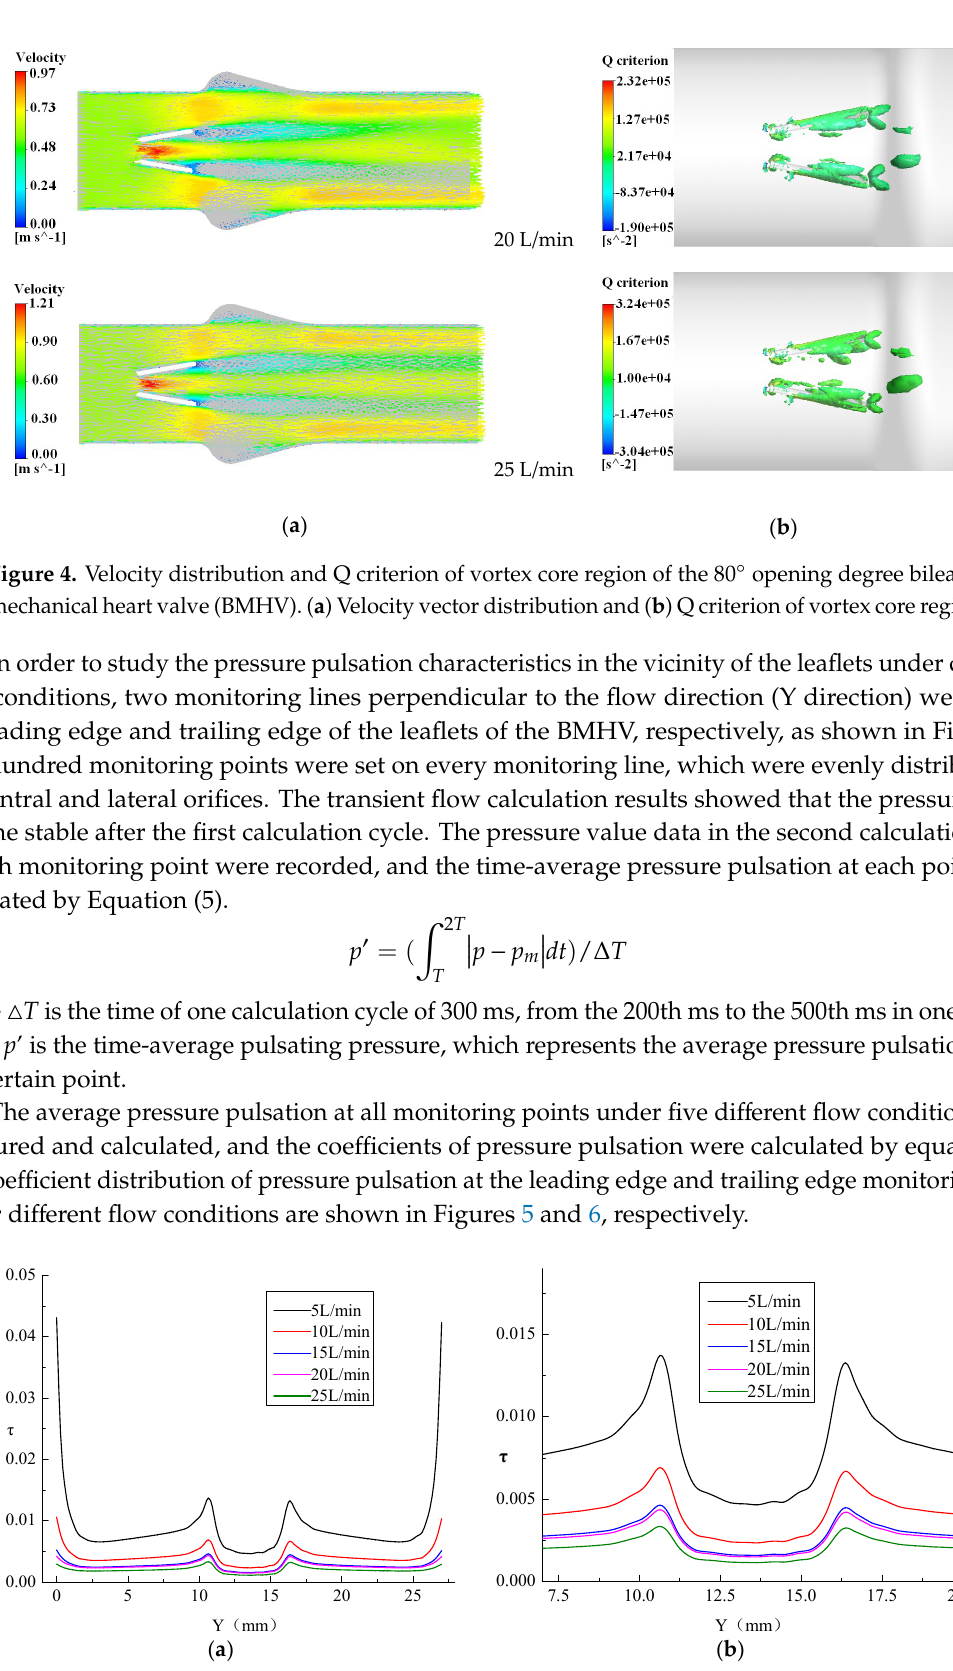
( b ) Figure 6. Coefficient distribution of pressure pulsation at the trailing edge monitoring lines under different flow conditions at 80° opening degree. ( a ) The complete view. ( b ) The local enlarged view. Figure 5a is the complete view of the coefficient distribution of pressure pulsation at the leading edge monitoring lines at flow rates from 5 L/min to 25 L/min. Figure 5b is the local enlarged view. Under different flow conditions, the level of pressure pulsation coefficient near the wall and the leading edge of the leaflets was higher. The level of the pressure pulsation coefficient in central and lateral orifices was relatively lower. As the flow rate increased, the distribution of the pressure pulsation coefficient on the leading edge monitoring line showed a trend of gradual decline, and the maximum value of pressure pulsation coefficient near the leading edge decreased from 0.014 to 0.003. The results show that the lower the flow velocity on the leading edges of the leaflets, the larger the coefficient of pressure pulsation. The flow velocity near the leading edges of the leaflets increased with the increased flow rate. The vortices fell off downstream, and the influence of the pressure pulsation decreased. Figure 6a is the complete view of the coefficient distribution of pressure pulsation at the trailing edge monitoring lines at flow rates from 5 L/min to 25 L/min. Figure 6b is the local enlarged view. Under different flow conditions, the coefficient of pressure pulsation near the trailing edge of the leaflets was relatively higher (the maximum value, equal to 8.4), which was reached at the trailing edges of the leaflets. At the main flow region, the coefficients of pressure pulsation in central and lateral orifices were close to zero. As the flow rate increased from 5 L/min to 15 L/min, the distribution of the pressure pulsation coefficient near the trailing edge decreased rapidly, with the